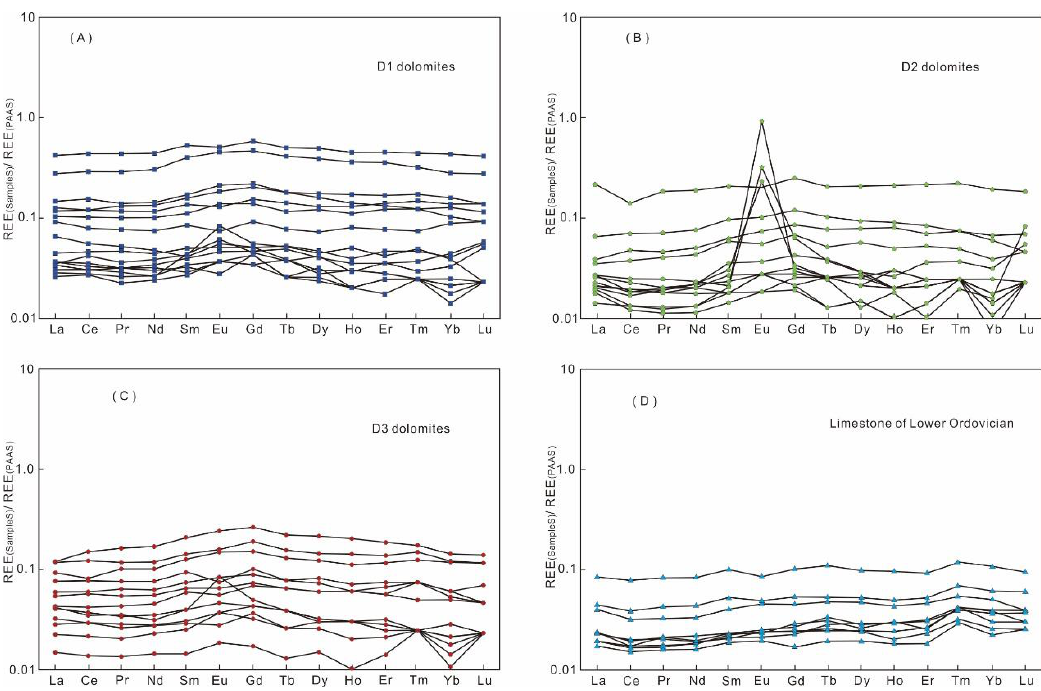
Figure 7. PAAS-normalized REE patterns of D1 dolomite ( A ), D2 dolomite ( B ), D3 dolomite ( C ), and limestone of Lower Ordoviciao ( D ) in the Bachu area, Tarim Basin. The PAAS data were obtained from McLennan (1989) [37]). The REE compositions of limestone of Lower Ordovician in Tarim Basin were obtained from Du et al. (2017) [28].